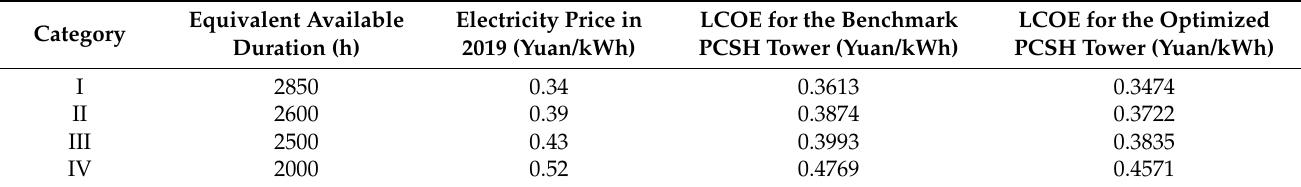
Figure 6. Optimization of costs of PCSH wind tower as a function of iteration number. Table 6. LCOE measurement.